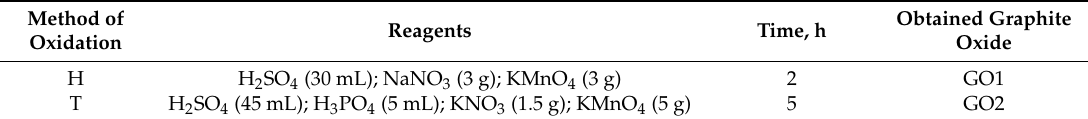
Table 1. Chemical reagents used in the oxidation